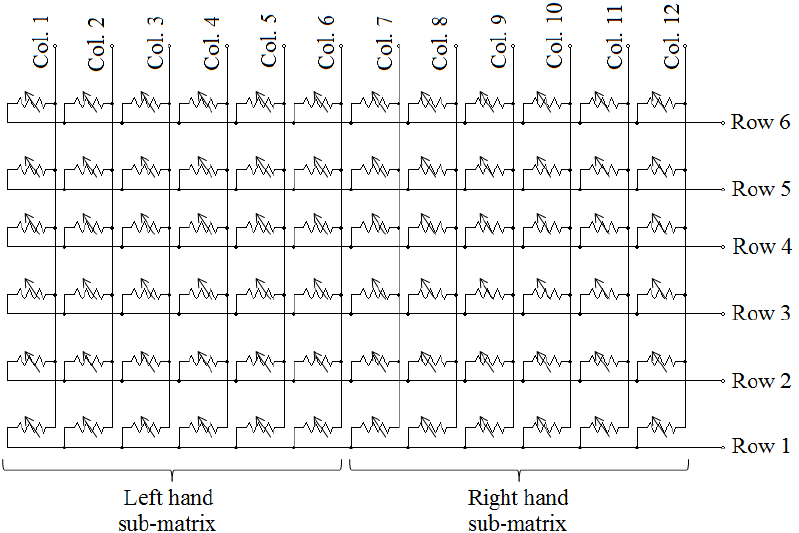
Figure 2. Piezoresistive matrix of the first prototype of tactile sensor.